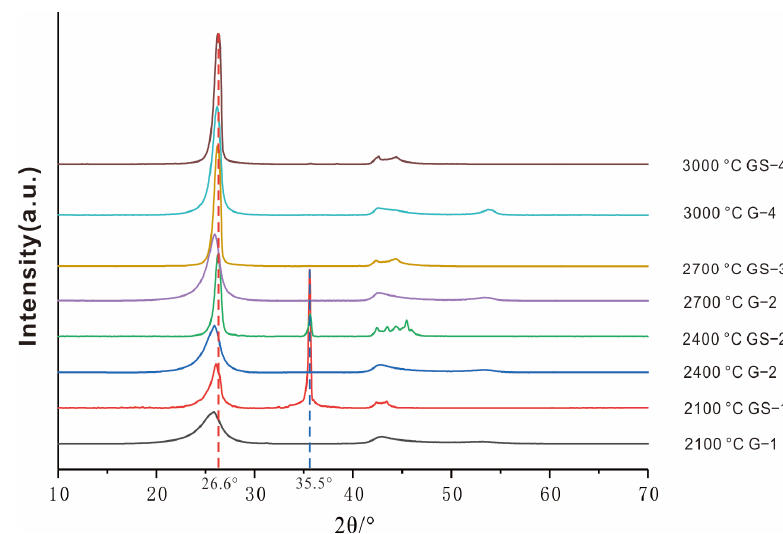
Figure 1. XRD pattern of experimental samples. Table 3. XRD parameters of experimental